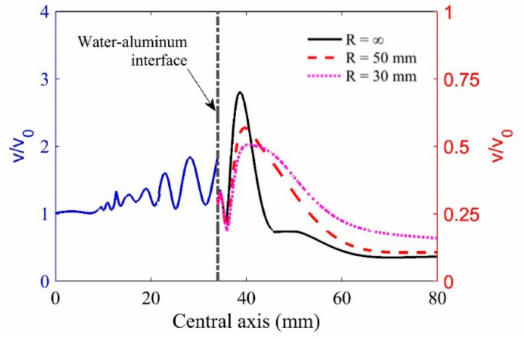
Figure 2. Particle velocities on the central axis in water–aluminum media at normal incidence.